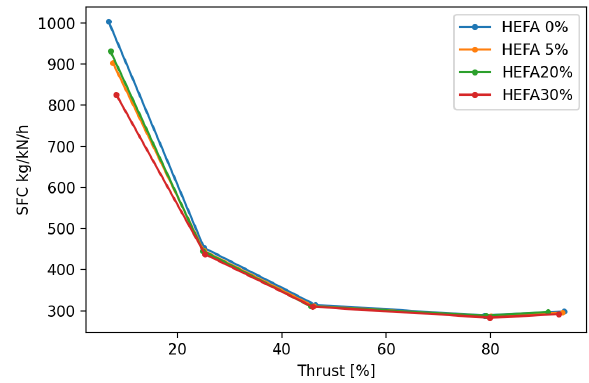
Figure 18. GTM-140/HEFA: SFC.